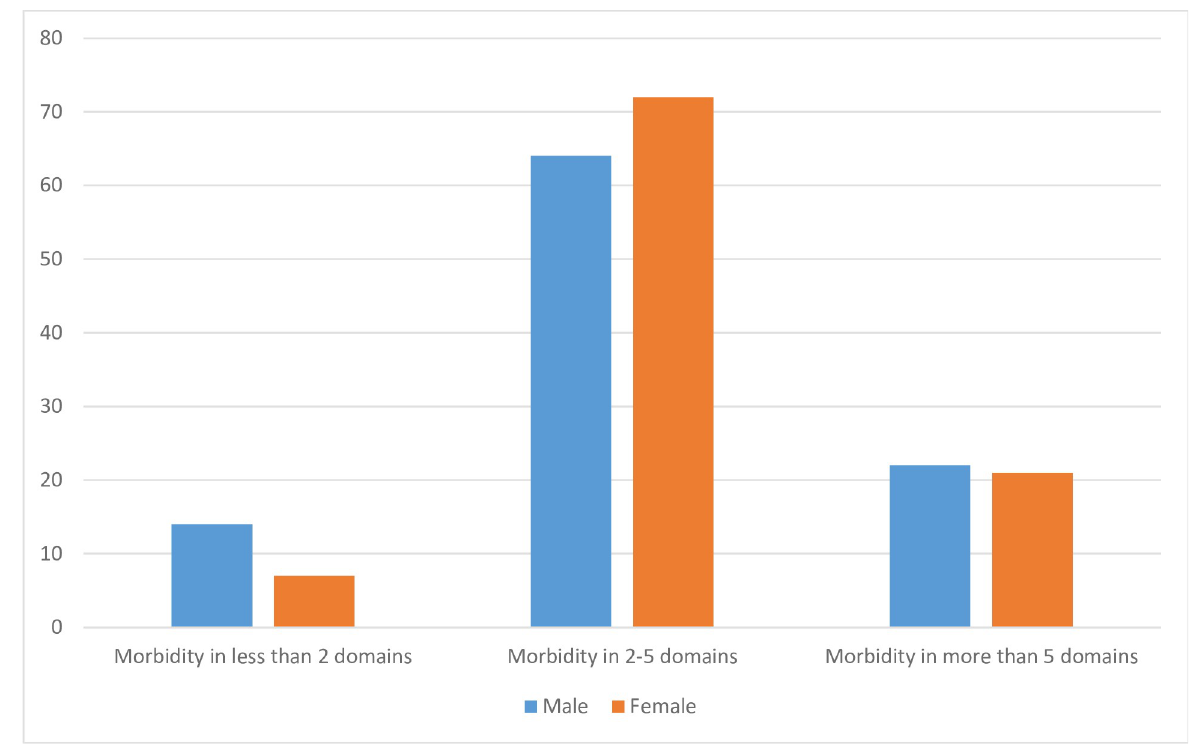
Fig 3. Distribution of multi-morbidity among indigenous older adults across